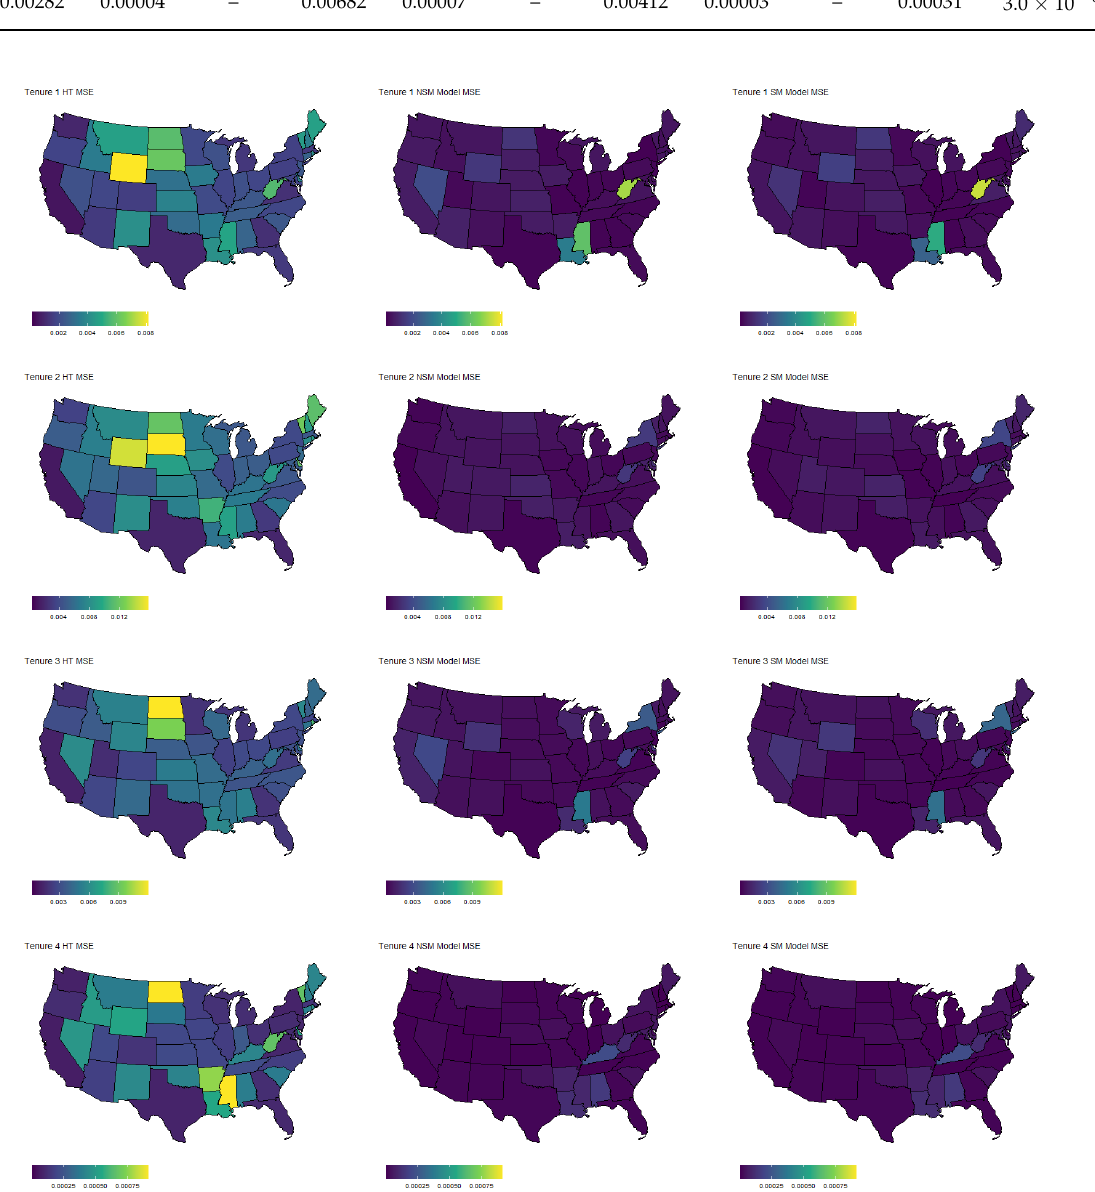
Figure 2. Map of MSE by state for each estimator and category. Data are based on the multinomial simulation using Week 1 of the Household Pulse Survey. The response variable is the housing status: own home with mortgage, own home free and clear, rent, and rent but unable to